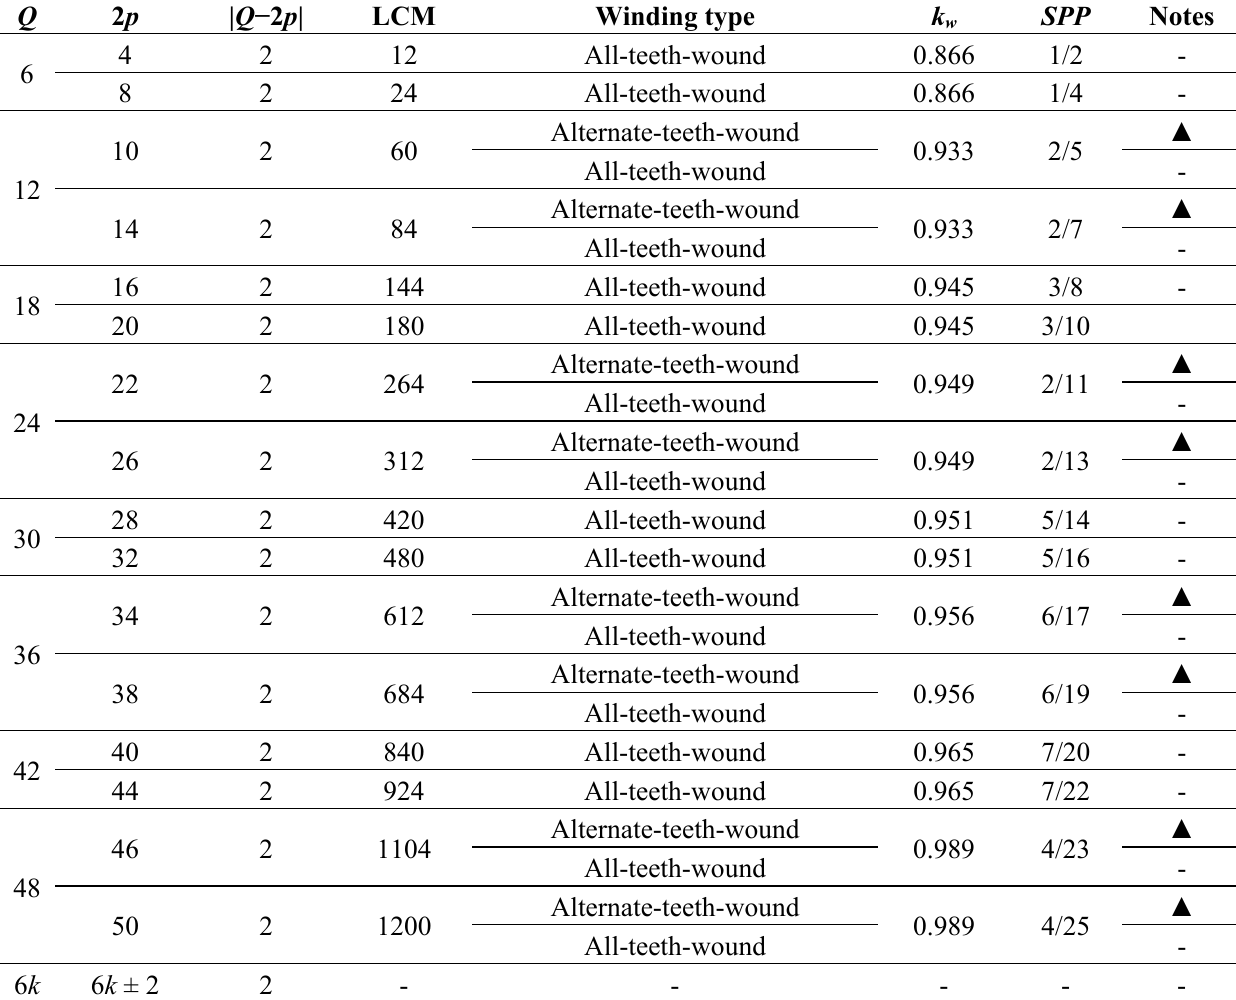
Table 1. Possible slot/pole combinations of the symmetric six-phase PMSM equipped with fractional-slot concentrated windings (FSCWs). Notes: ▲ means the combinations enable alternate-teeth-wound